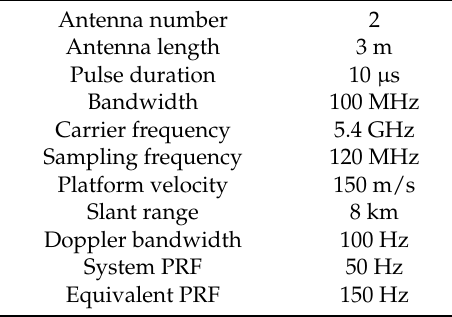
Table 1. Parameters used in the